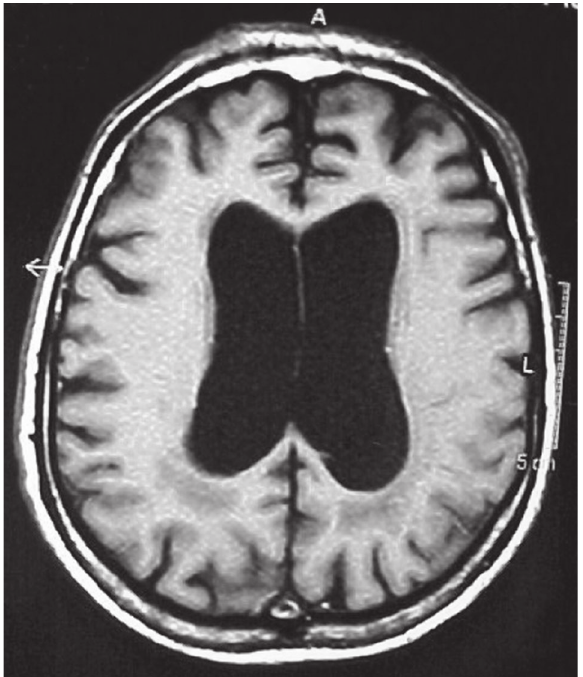
Figure 4. Case 4 – RM (T1 axial) showing hy drocephalus and hypoin- tense white matter (periventricular) foci (mainly posterior).